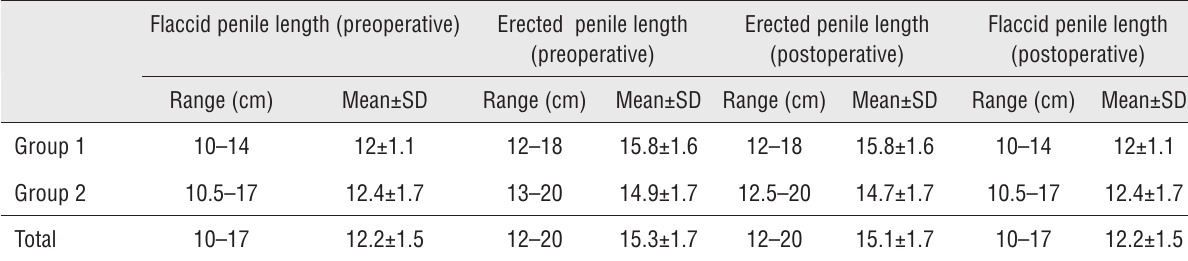
Table 2 - Pre and postoperative flaccid and erected penile length. Flaccid penile length (preoperative) Erected penile